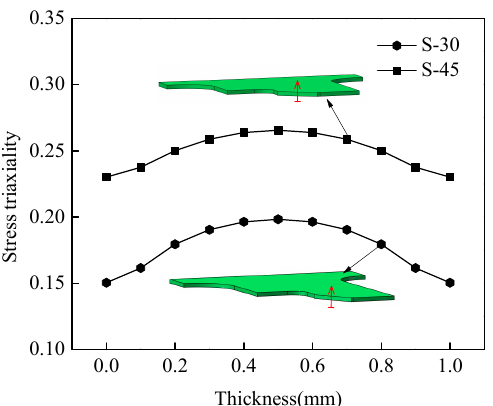
Figure 10. Stress triaxiality along center line of minimum cross-section in thickness direction for shear-dominated specimens.